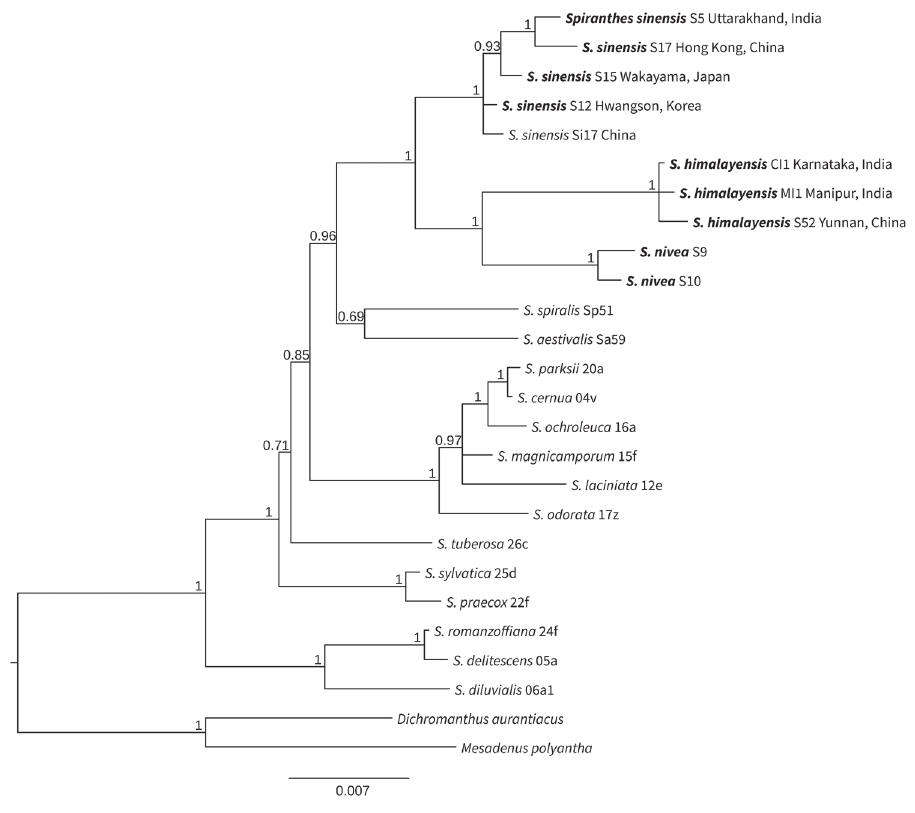
Figure 1. Bayesian phylogenetic tree indicating Spiranthes himalayensis Survesw., Kumar & Mei Sun sp. nov. Sequences generated for this study are indicated in bold, specimen identification numbers and area of collection are indicated beside the species names. Bayesian probability supports are indicated at the